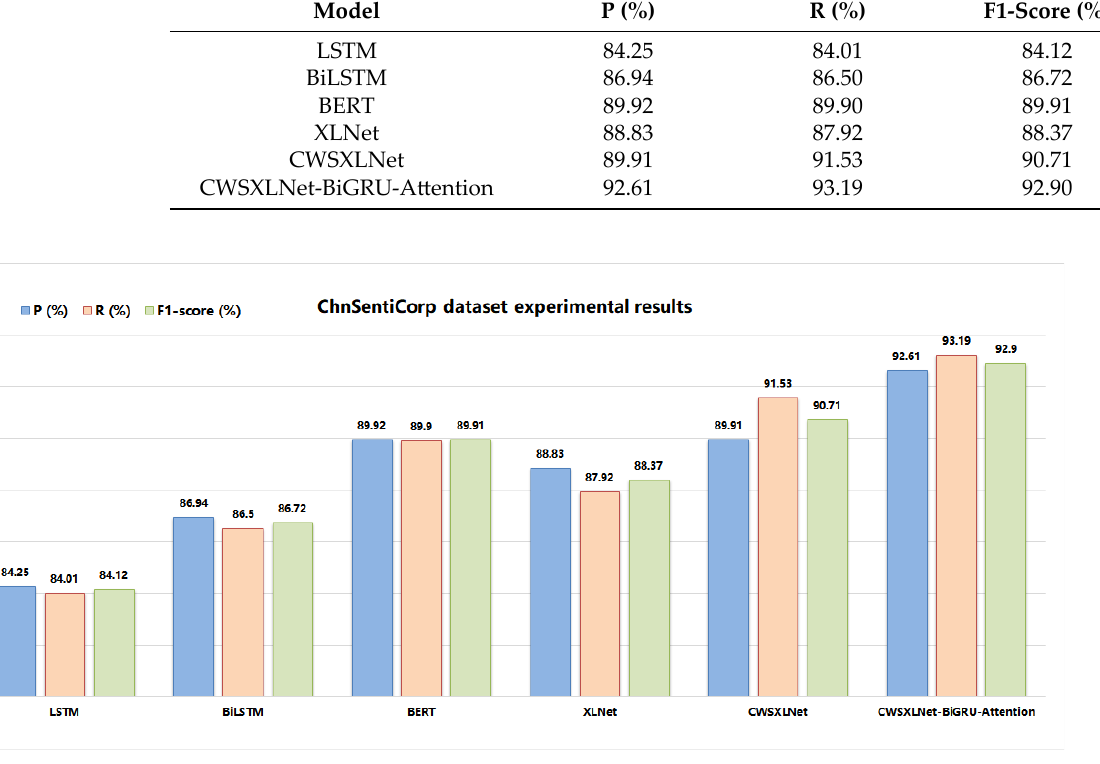
Figure 13. ChnSentiCorp dataset experimental